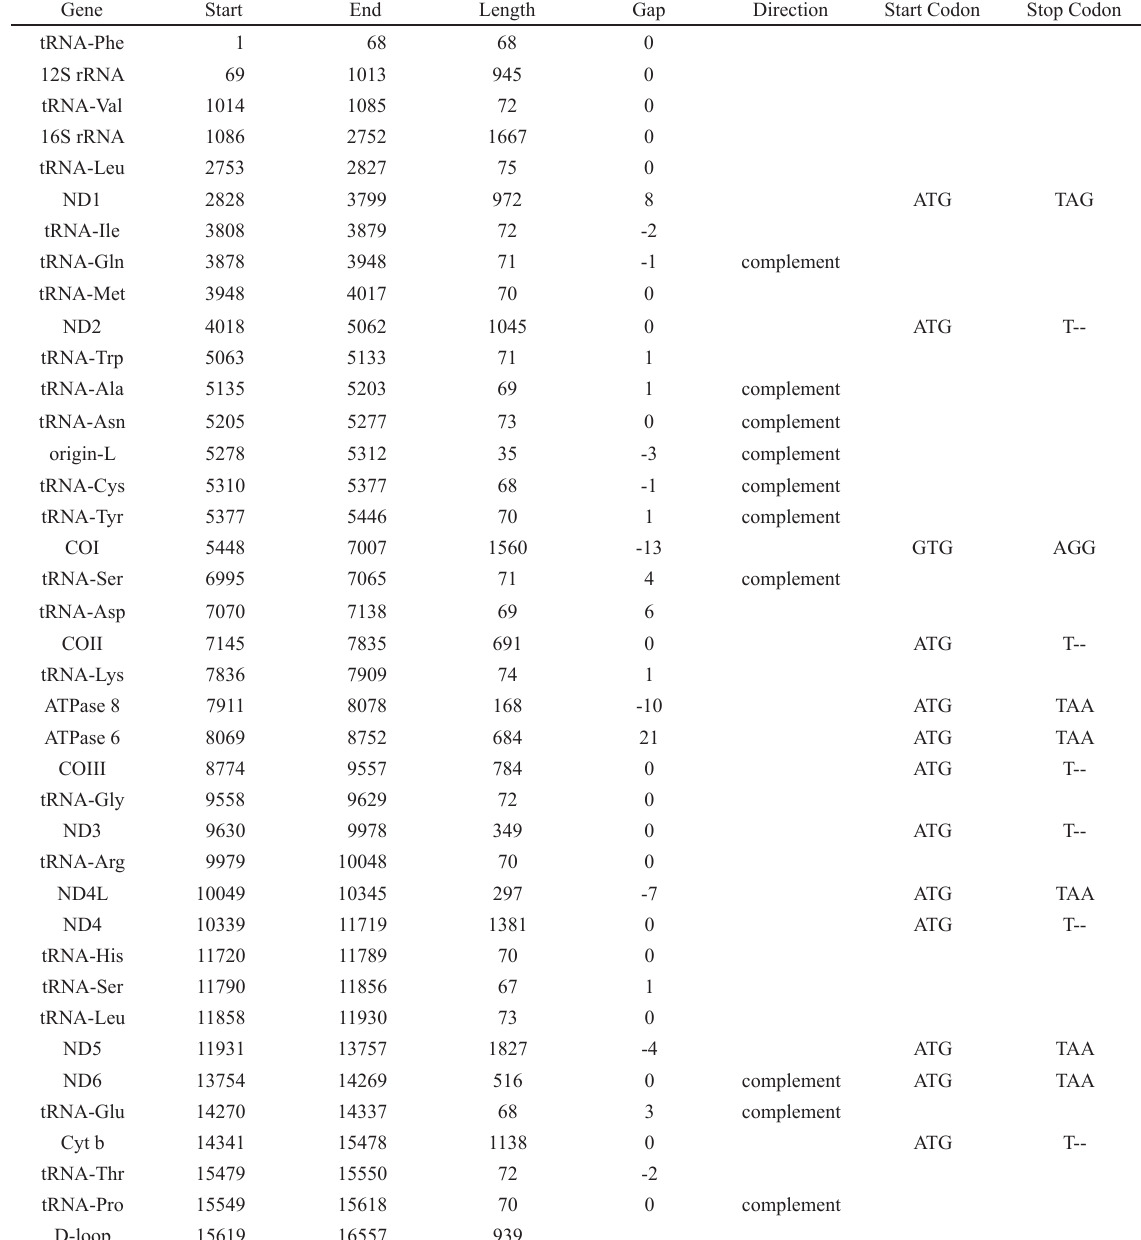
Fig. 2. Sequencing depth over the complete mitogenomes of the three individuals of Corydoras nattereri : KT239008 (A), KT239009 (B), and KT239010 (C). Read counts (y-axis) are shown in logarithmic scale and sharp decreases correspond to the punctuation model of mitochondrial transcription (positions correspond to those shown in Fig. 1 and Table 3). Black vertical bars indicate position of gaps that were fi lled with Sanger sequencing (Table 2). Reads were mapped to the mitogenomes using Bowtie and visualized at the Integrative Genome Viewer (IGV, Bernt et al ., 2013; Thorvaldsdóttir et al ., 2013). Table 3. Positioning of genes in the mitochondrial genome of Corydoras nattereri . Negative gap values indicate